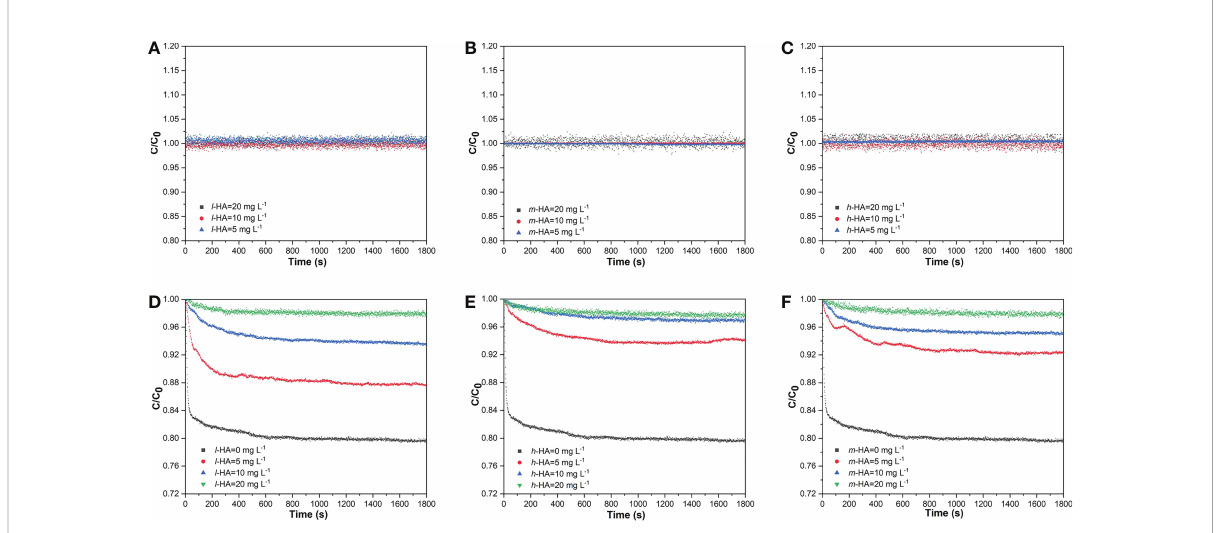
FIGURE 2 Effects of different HA fractions ( l -HA, and h-HA) with various concentration on the sedimentation of MPs as a function of time. (A – C) the sedimentations of different HA fractions (D – F) the sedimentation of MPs in the presence of different HA